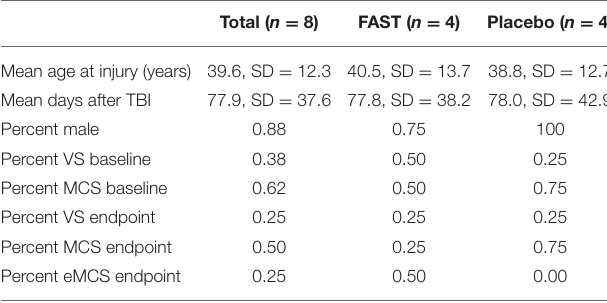
TABLE 1 | Pilot study imaging Subgroup